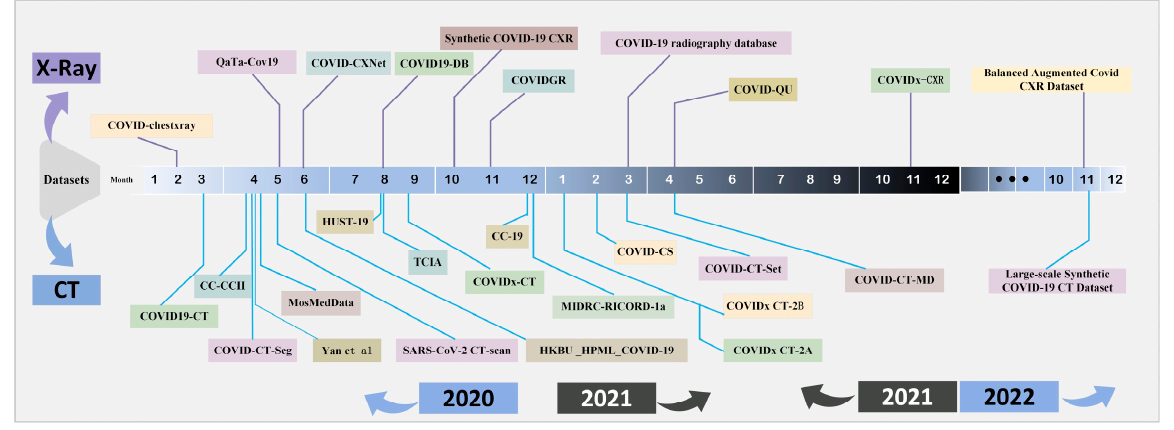
Figure 4. COVID-19 dataset. Table 1. COVID-19 public